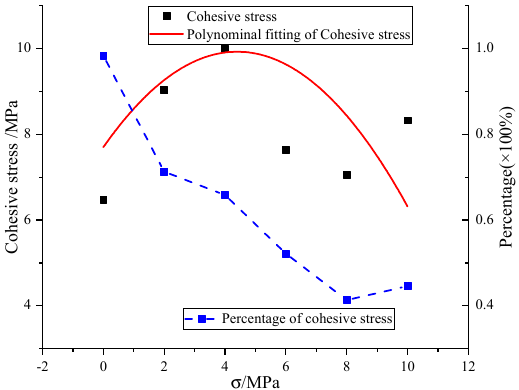
Figure 10. Relationship between cohesive stress and axial pressure.